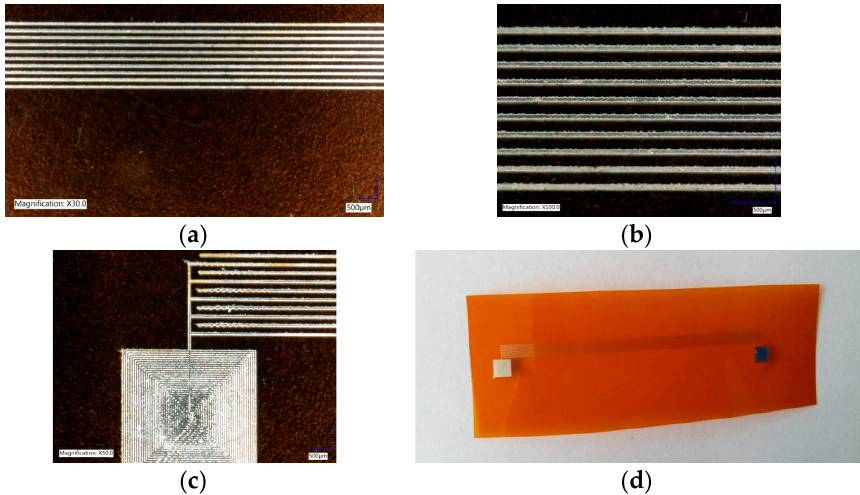
Figure 2. Micrographs of the printed sensor electrodes and contact pads; ( a ) general view with Magnification ×30.0; ( b ) zoom to electrodes with Magnification ×100.0; ( c ) zoom to contact pad with Magnification ×100.0; ( d ) photograph of the sensor substrate.